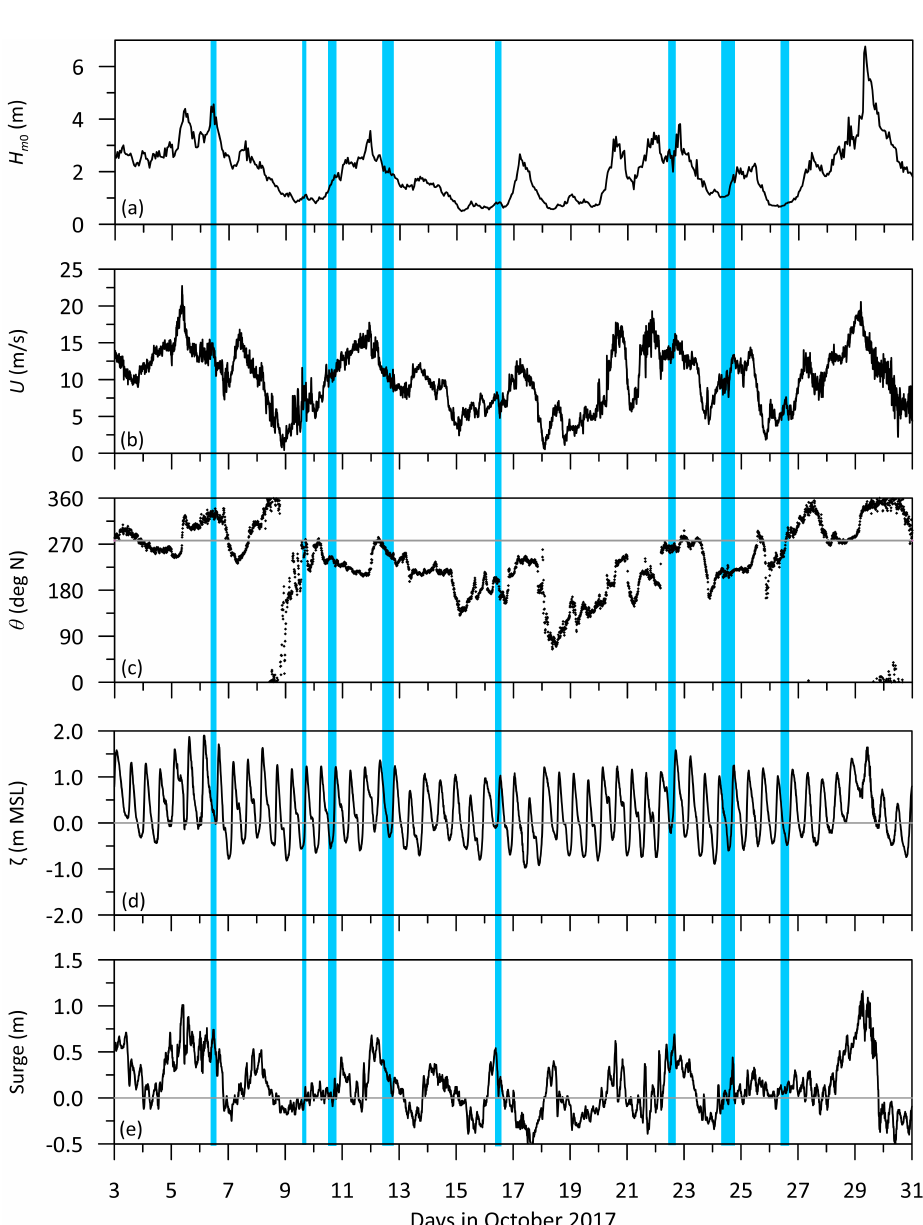
Figure 2. Time series of offshore ( a ) significant wave height H m 0 , ( b ) wind speed U , ( c ) wind direction θ with respect to north (N = 0 and 360 ◦ , E = 90 ◦ , S = 180 ◦ , W = 270 ◦ ), ( d ) water level ζ with respect to Mean Sea Level and ( e ) surge level during Aeolex-II. The sky-blue vertical bars represent the moments when surface moisture data were collected. The surge level was estimated as the difference between the measured and (predicted) astronomical water level. The horizontal gray line in ( c ) is the shore-normal direction, 277 ◦